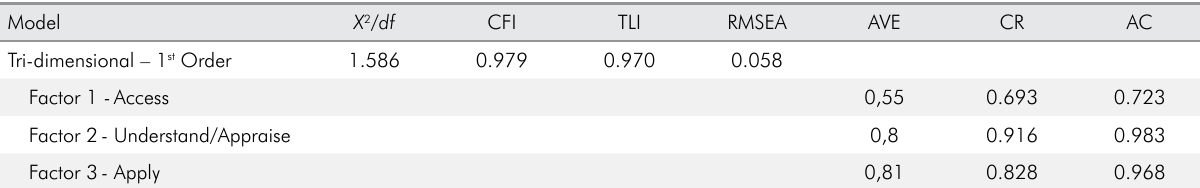
Table 2. Analysis of goodness-of-fit of the dimensional structures of Oral Health Literacy among people with Diabetes questionnaire. Model